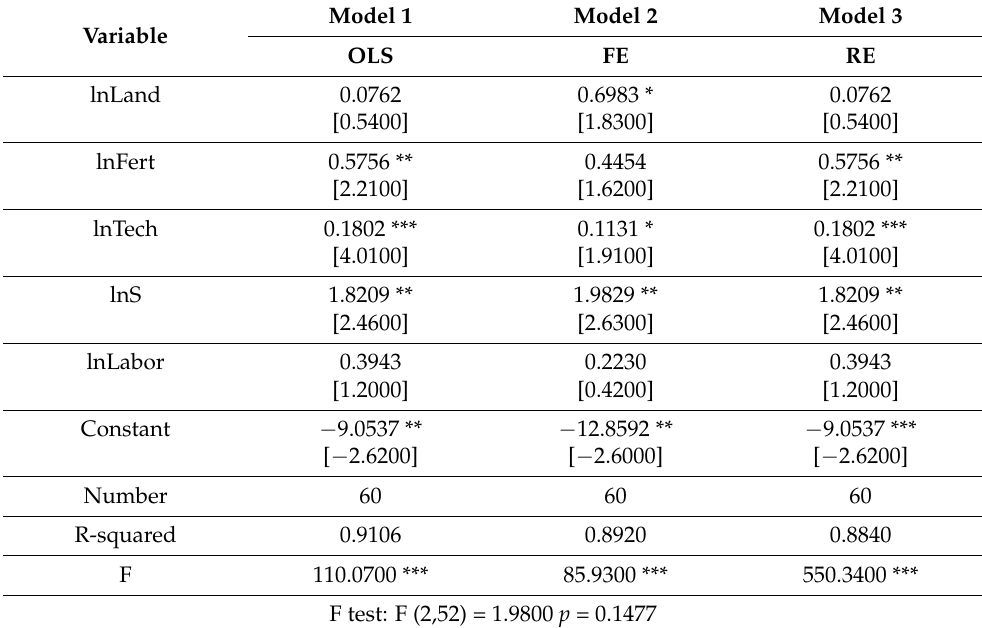
Table 9. Panel model determination and regression